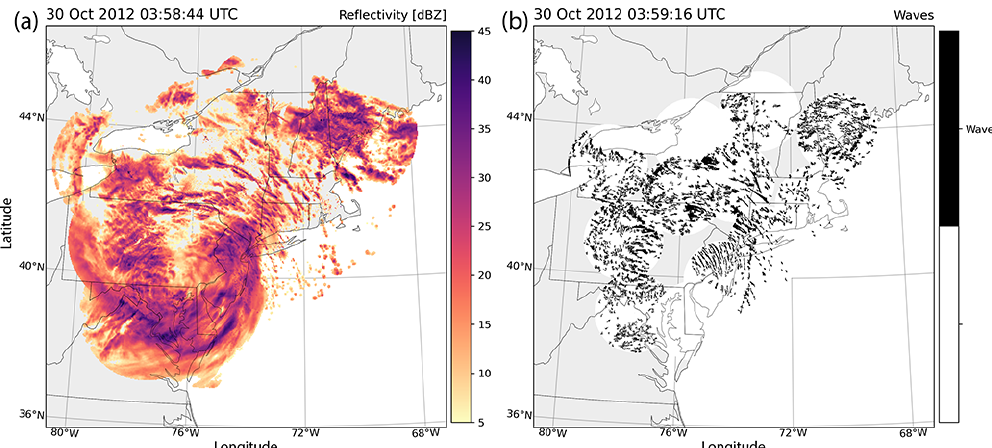
Figure 8. (a) Regional radar maps of reflectivity and (b) elongated bands of velocity perturbations detected in radial velocity data for Hurricane Sandy on 30 October 2012 at 03:58UTC. Data are from 12 NWS radars in the northeastern US. An animated version of this figure is in Video Supplement